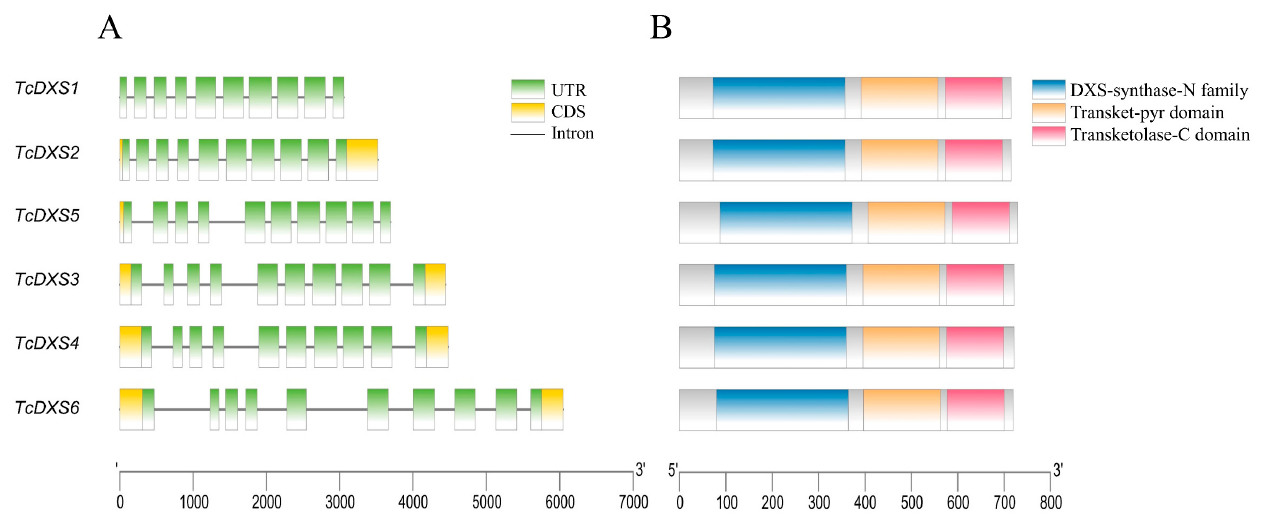
Figure 2. Chromosome location of the TcDXSs gene family in T. ciliata .